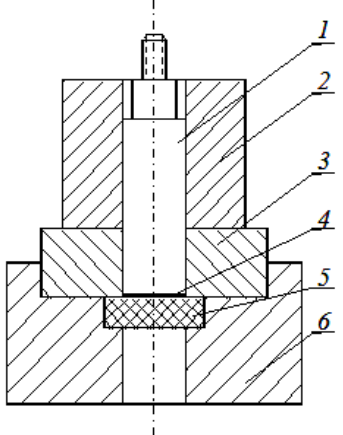
Figure 3. Diagram of the device for preparing samples for testing: 1-stock; 2-load; 3-fluoroplastic sleeve; 4-mineral binder; 5-wood; 6-pallet.